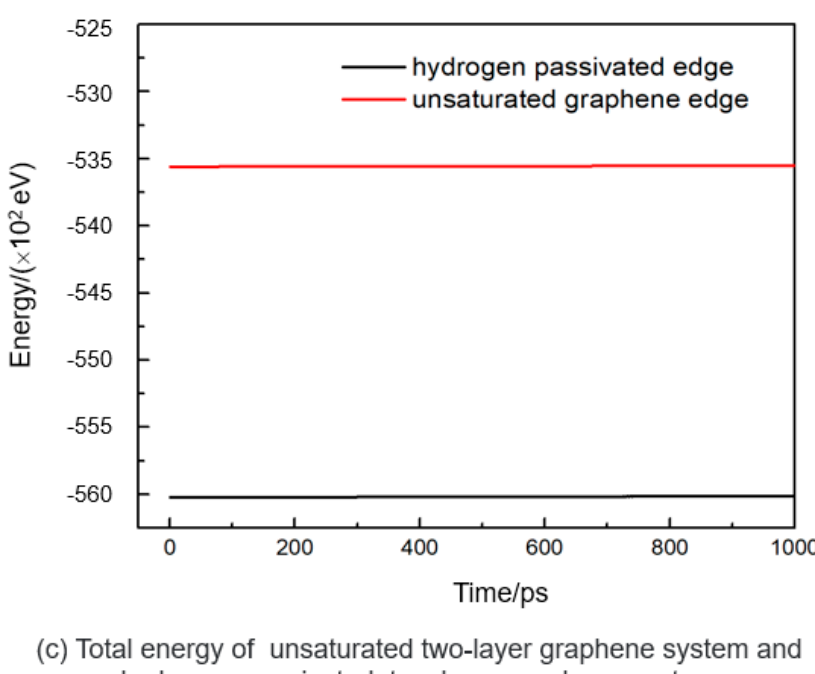
Figure 18. ( a )Exfoliation process of the unsaturated two-layer graphene system, ( b ) exfoliation process of the hydrogen-passivated two-layer graphene system, and ( c ) the total energy of them.